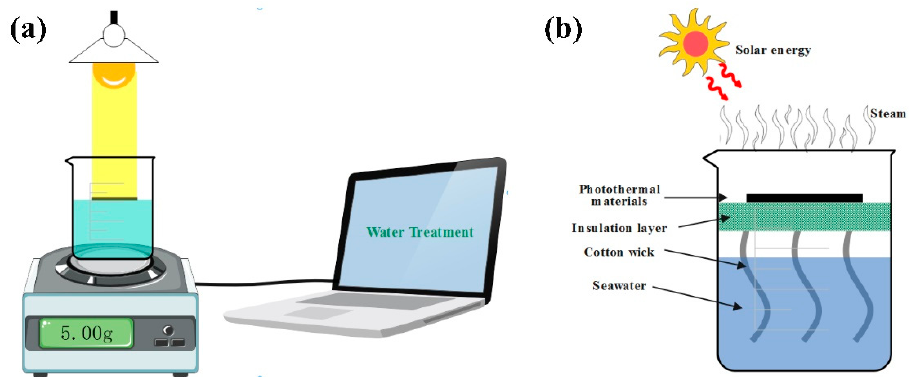
Figure 10. ( a ) Schematic diagram of SSG system experimental platform. ( b ) Schematic diagram of the photothermal conversion device.